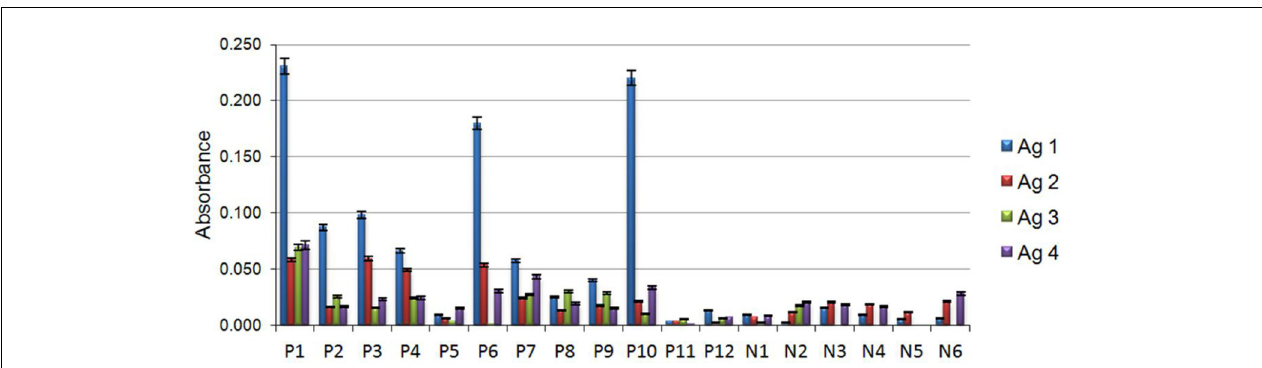
FIGURE 4 | Individual data from immunoassays with antigens existing on the serum of patients with chromoblastomycosis (P), patients without chromoblastomycosis (N). Antigens were assessed to determine their capacity of reaction in the formation of immune complexes with wall polysaccharides of the fungus F. monophora